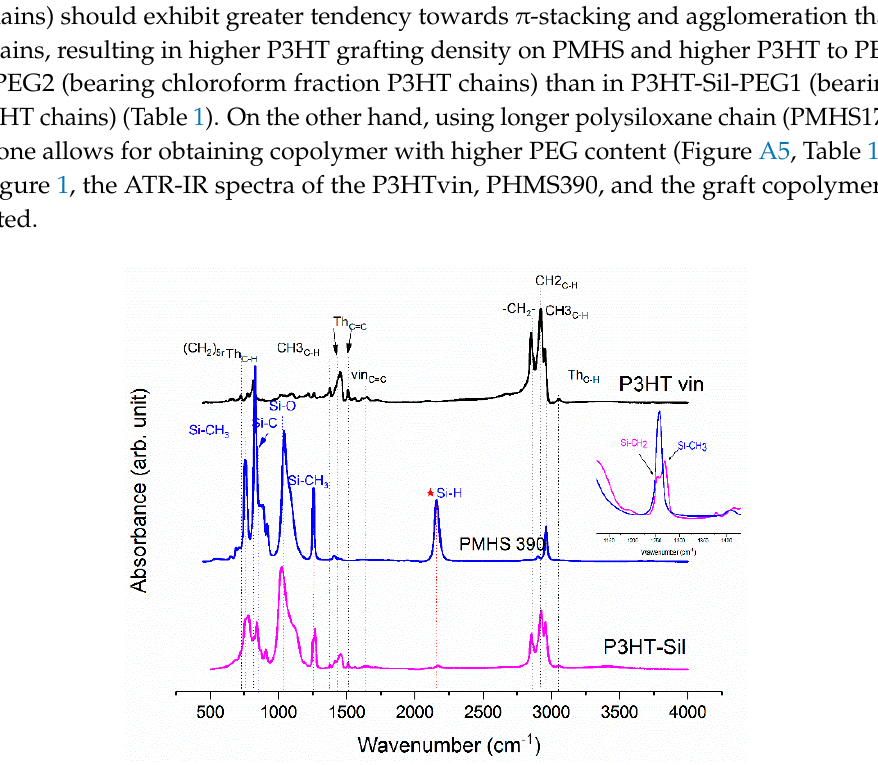
Figure 1. IR-ATR spectra of graft copolymer P3HT-Sil, vinyl terminated regioregular P3HT, and PMHS.